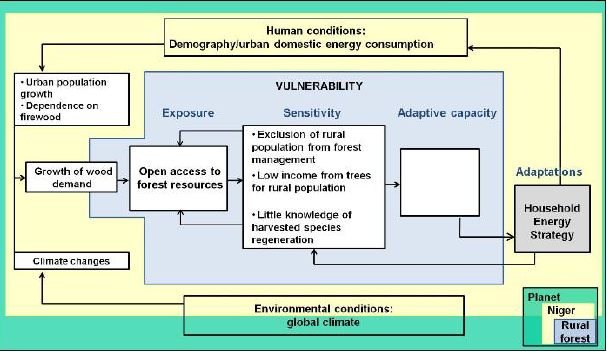
Fig. 1 . Degradation diagnosis underlying the Household Energy Strategy analyzed as a vulnerability diagnosis (adapted from Turner II et al.